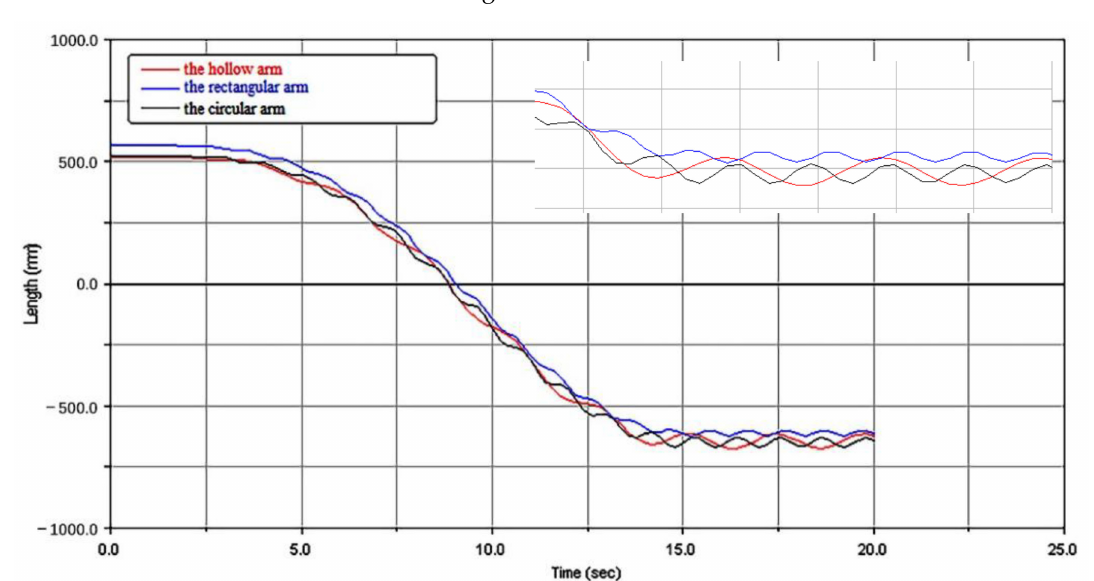
Figure 13. Displacement distribution with different arm structures.